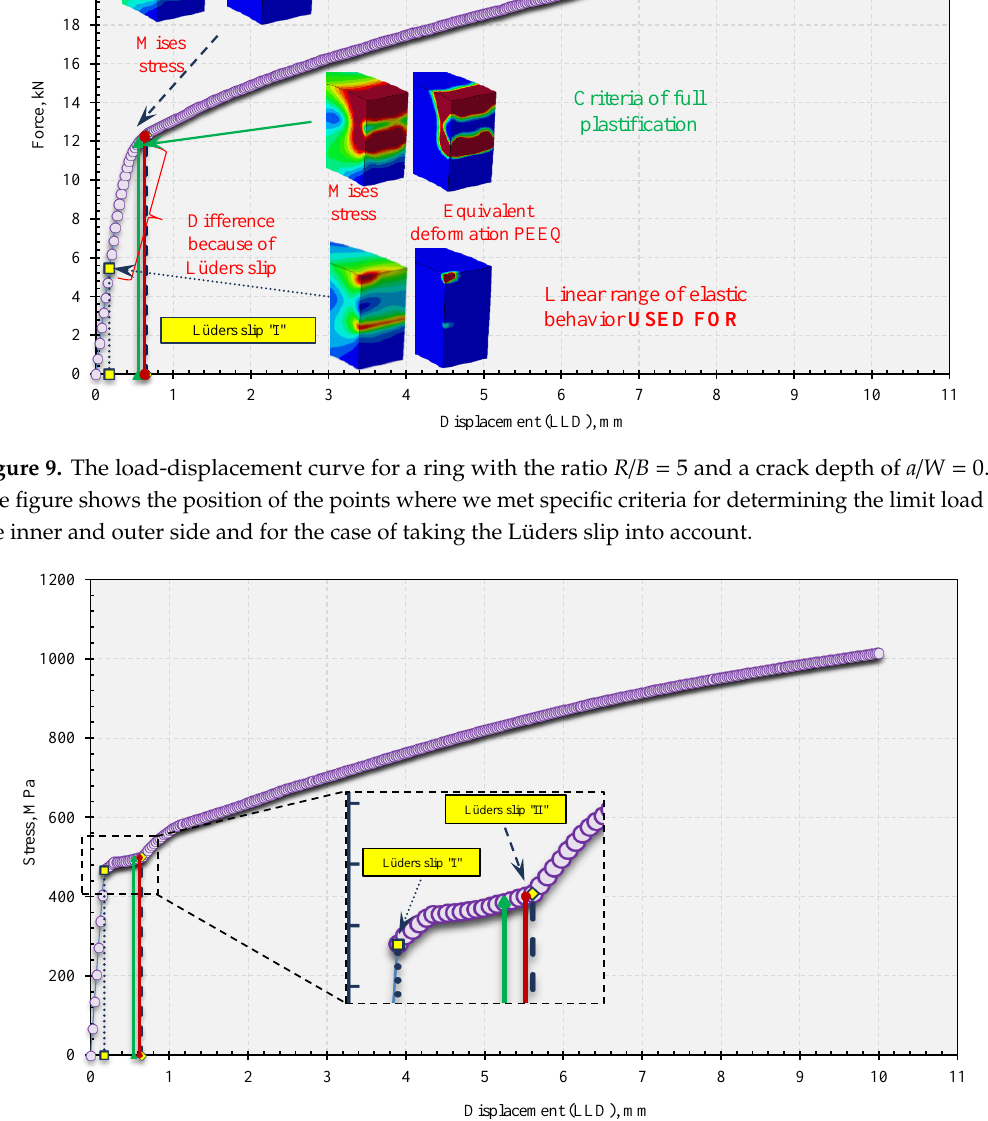
Figure 10. Displayed range with points for determining the limit load from the stress-displacement curve ( R / B = 5 with a / W = 0.45) the position of Lüders slip ‘‘I’’ and Lüders slip ‘‘II’’. The limit load determination is based on the assessment of the position of this point, see Figure 10 (stress-displacement curve of the ring R / B = 5, a / W = 0.45), and the determination of the corresponding displacement, which we estimated from Figure 9 as F Y . In all cases of the rings we analyzed, F Y was much lower than from the criterion of full plastification through the unbroken ligament. The deformation at this time was only noted and visible at the contact point (s) [4,5].